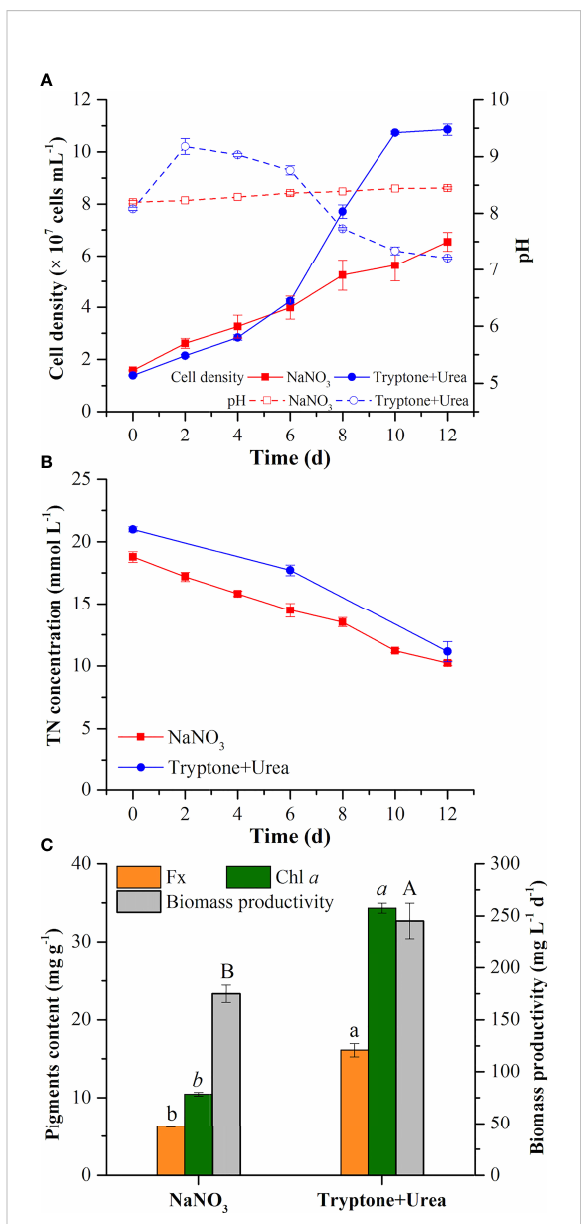
FIGURE 1 Cell density and pH value (A) , total nitrogen concentration in the medium (B) , pigment (fucoxanthin and chlorophyll a ) contents, and biomass productivity (C) in the mixotrophic growth of Phaeodactylum tricornutum using inorganic (NaNO organic nitrogen (tryptone:urea = 1:1, mol N:mol N) sources at 20 mmol N L − 1 . Different letters indicate a signi fi cant difference ( p< 0.05).